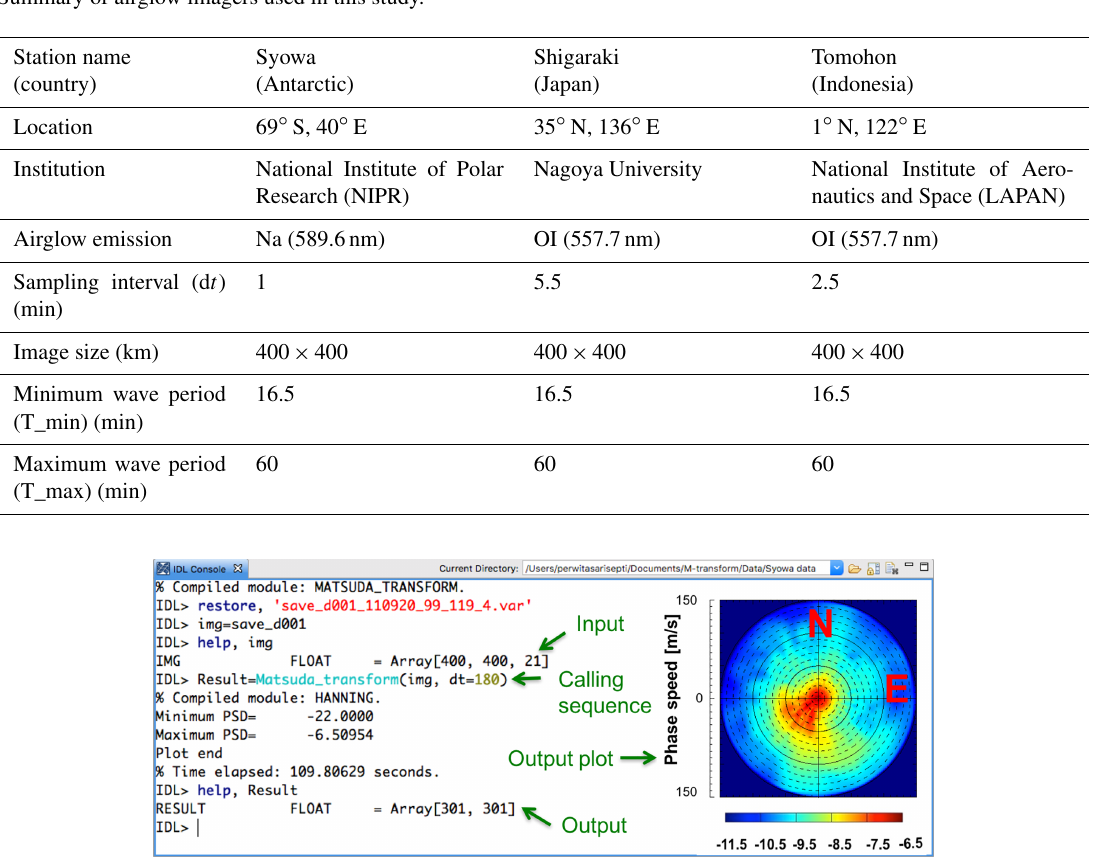
Table 2. Summary of airglow imagers used in this study.